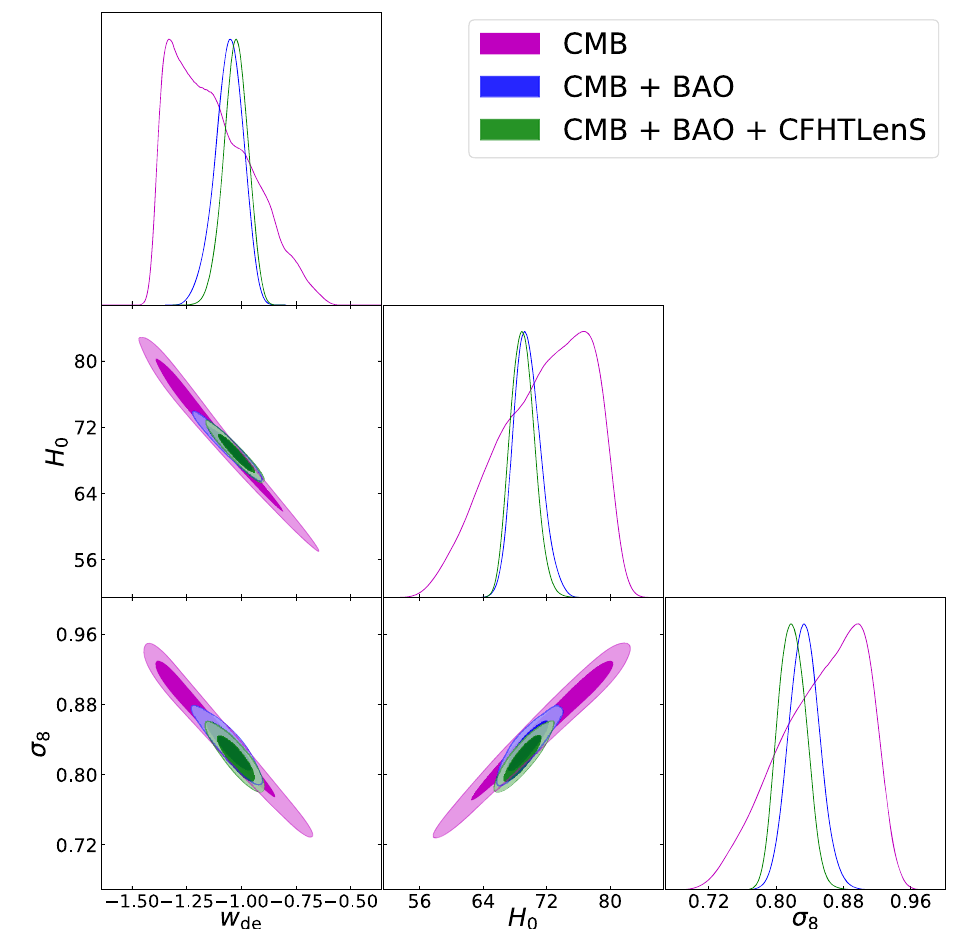
Fig. 2 One-dimensional marginalized distribution, two-dimensional 1 σ and 2 σ confidence contours for some selected parameters